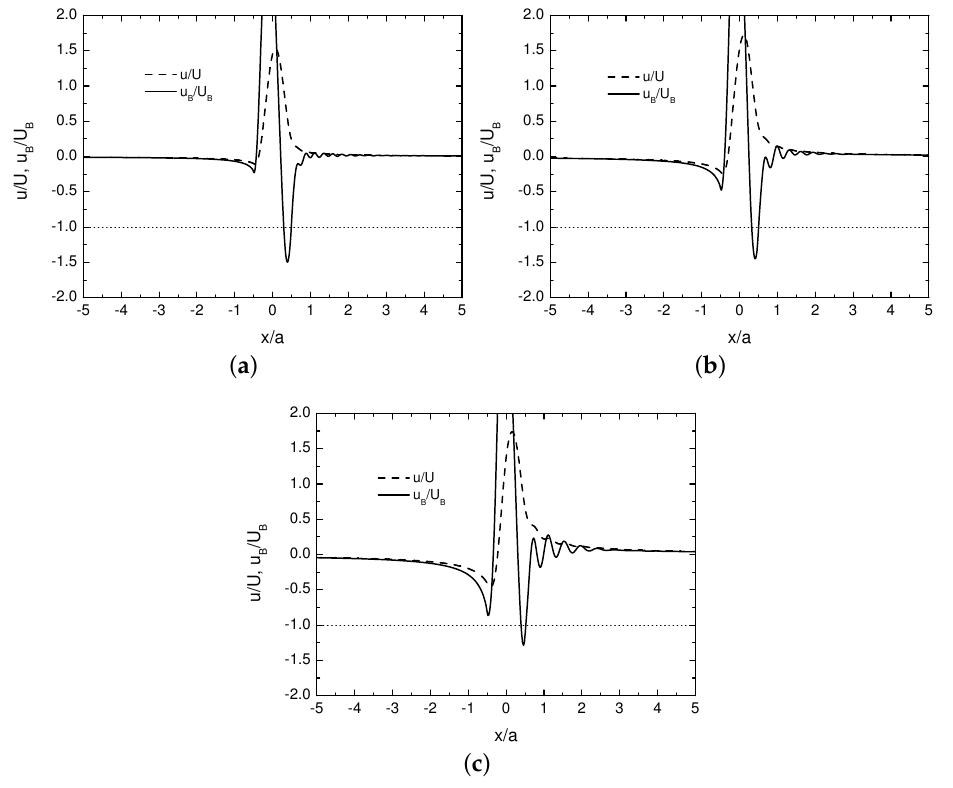
Figure 3. Similar to Figure 2, except that ( a ) Fr = 0.7, ( l 2 H ) − 1 = 2; ( b ) Fr = 0.8, ( l 2 H ) − 1 = 2; ( c ) Fr = 0.9, ( l 2 H ) − 1 =